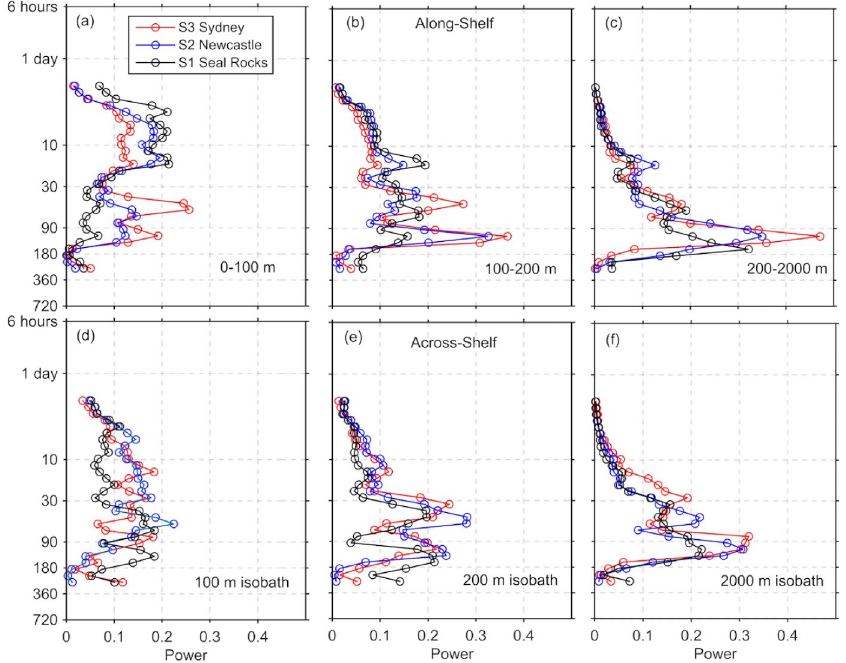
Fig 10. Morlet wavelet global power spectrum calculated from the daily transport timeseries, for the along-shelf transport through each of the shelf sections. (a) 0-100m, (b) 100-200m and (c) 200-2000m and for the across-shelf transport across the (d) 100m (e) 200m and (f) 2000m isobaths. Colours show the transports for each section at Seal Rocks S1, S1x, Newcastle S2, S2x, and Sydney S3, S3x in the along and cross-shelf direction, respectively.